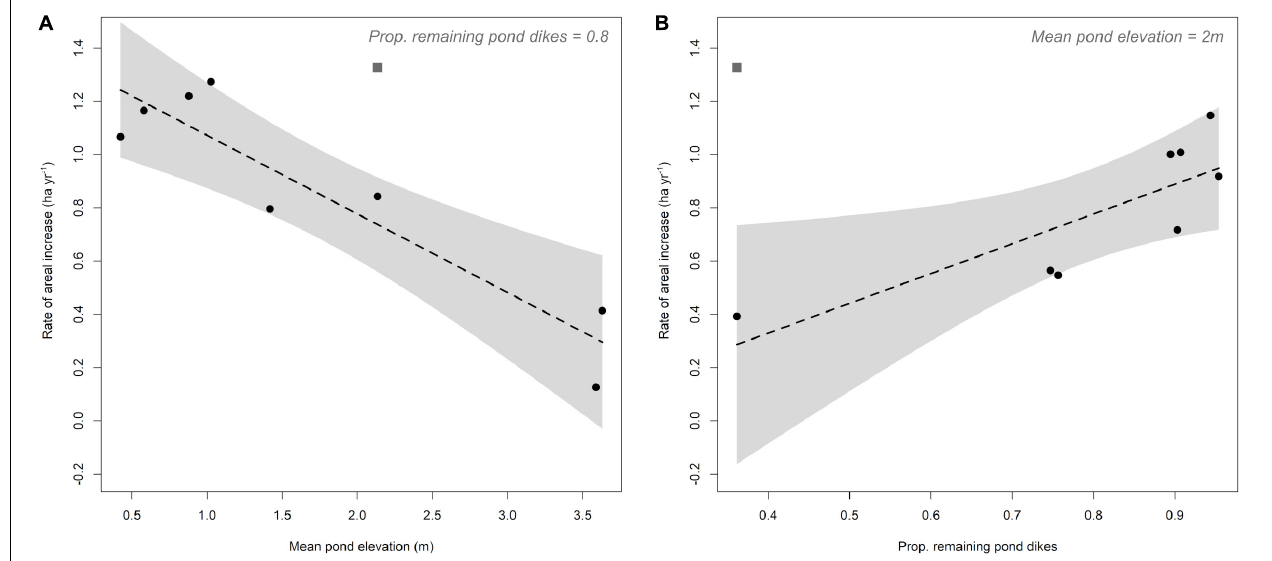
FIGURE 4 | Partial regression plots from the best-fitting linear regression model for “rate of areal increase” [mean pond SRTM DEM elevation (m; β 1) + proportion of remaining pond dikes ( β 2)] for naturally-regenerating (NR) abandoned aquaculture ponds – black circles [model: intercept = 0.47 ± 0.35 (1 s.e.), β 1 = –0.30 ± 0.06 (1 s.e.), β 2 = 1.12 ± 0.37 (1 s.e.), 5 d.f., t1 = –5.18, t2 = 3.00, p = 0.002, multiple R 2 = 0.91]. (A) Partial regression plot of the relationship between rate of areal increase (ha year − 1 ) and mean pond SRTM DEM elevation (m), where proportion of remaining pond dikes = 0.8; (B) partial regression plot of the relationship between rate of areal increase and proportion of remaining pond dikes, where mean pond SRTM DEM elevation = 2 m. The dark gray square in each partial regression plot denotes the rate of areal increase observed under assisted natural regeneration [ANR (planting): 2009–2013] at the Leganes Katunggan, Iloilo abandoned pond. Gray shaded areas delimit the 95% confidence intervals of the partial regression model